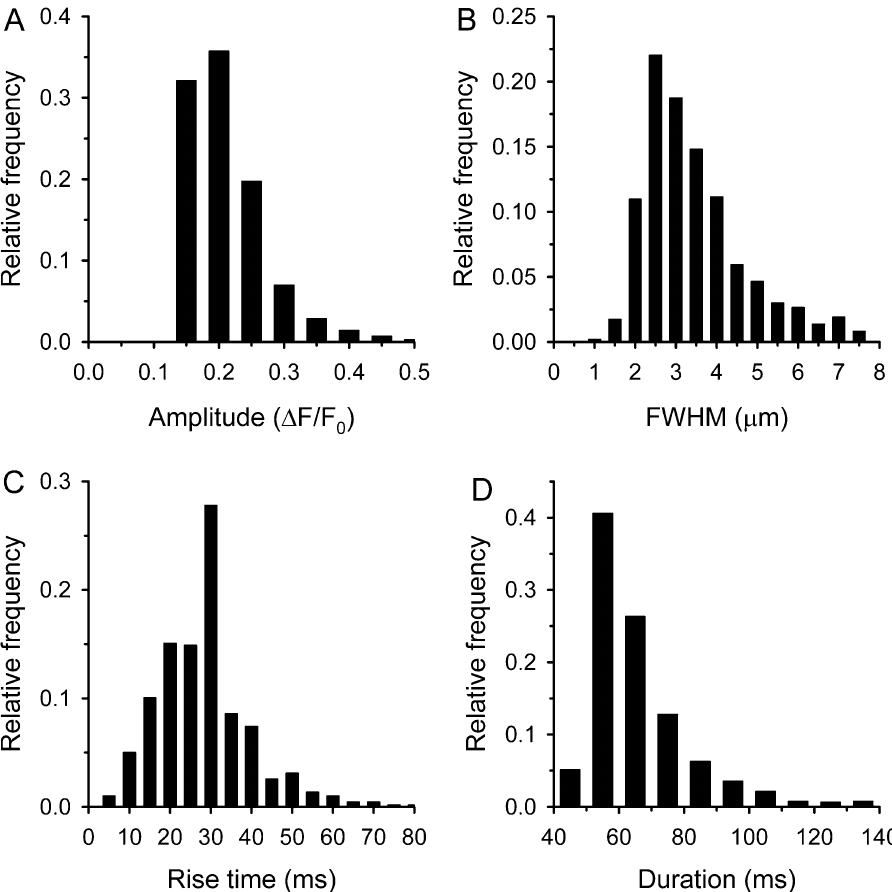
Figure 6. Parameters of calcium embers. Histogram of amplitudes ( A ), FWHMs ( B ), rise times ( C ), and durations ( D ). The number of embers was 1094.